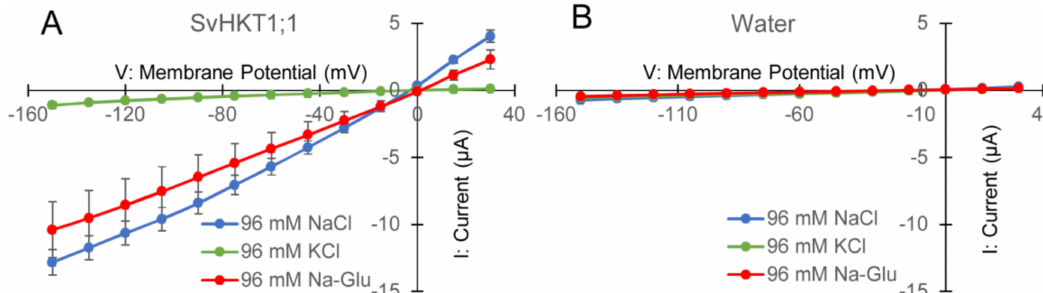
Figure 4. Analyses of SvHKT1;1-mediated ion transport by two electrode voltage clamp experiments using Xenopus laevis oocytes. Current–voltage relationship of oocytes injected with 12.5 ng of SvHKT1;1 complementary RNA (cRNA) ( A ) or water ( B ) bathed in solutions containing an indicated amount of NaCl, KCl, or Na-gluconate. Voltage steps ranged from − 150 to + 30 mV with 15-mV increments. Data are presented as means ± SD ( n =